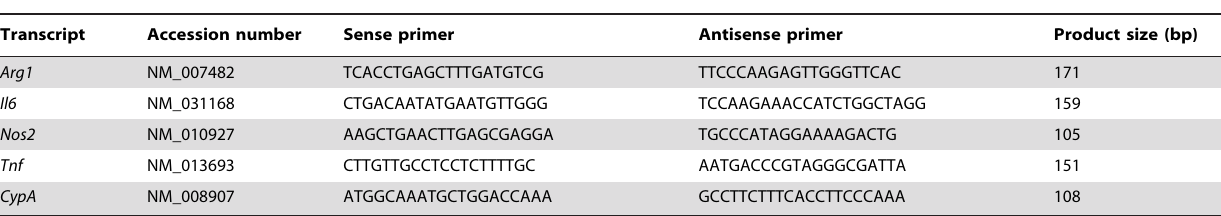
Table 2. Primers used in PCR